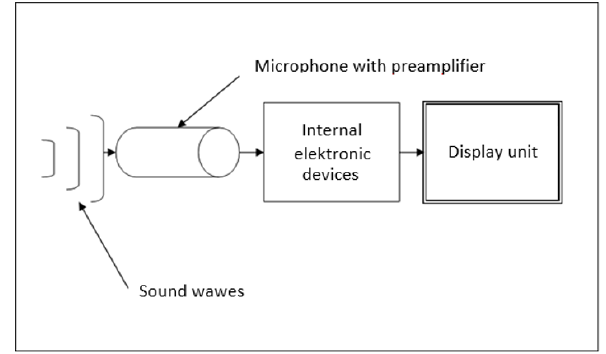
Figure 1: Sound measurement by sound level